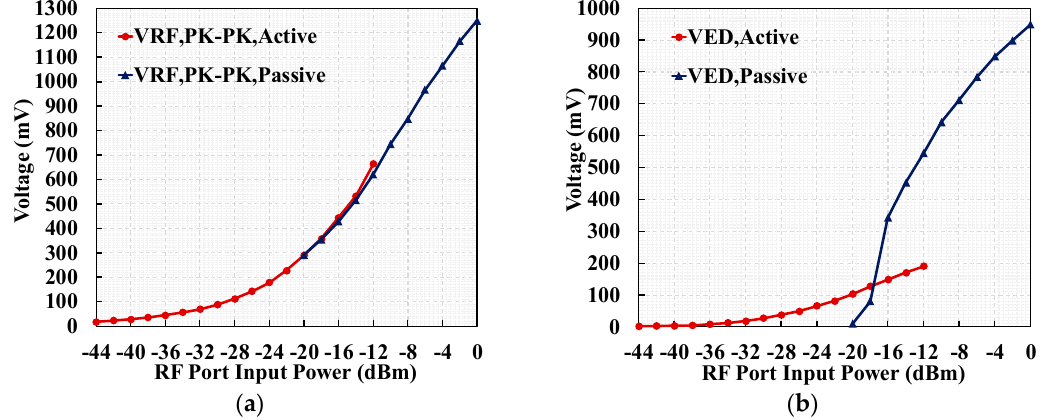
Figure 8. ( a ) Amplitude of the input RF signal versus input RF power; ( b ) amplitude of the envelope detector’s output signal versus input RF power.